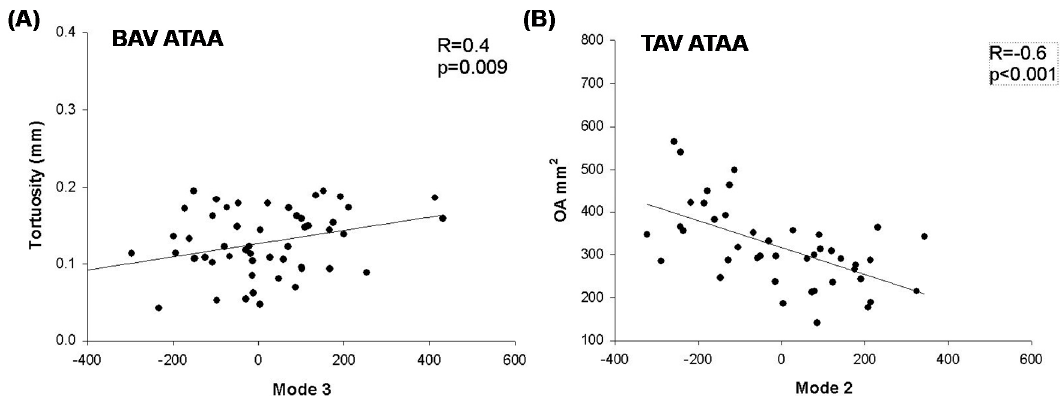
Figure 4. Correlations ( A ) between Mode 3 and vessel tortuosity for BAV ATAA and ( B ) between Mode 2 and orifice area for TAV ATAA.